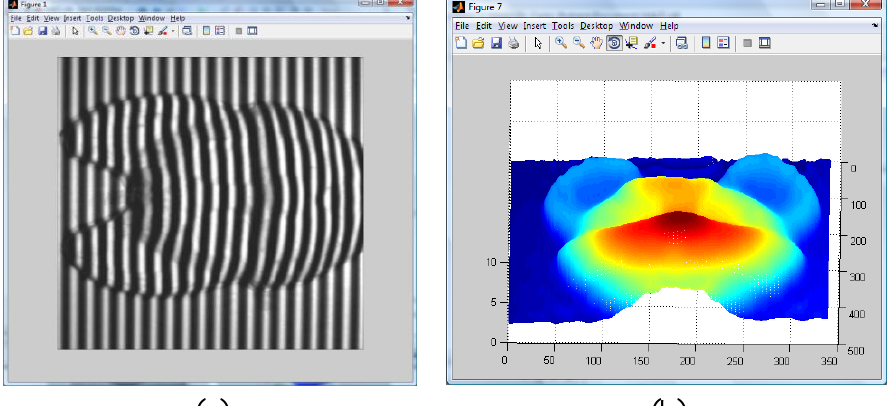
Figure 10. Real objects (a), (c), and (e), and their respective reconstruction (b), (d) and (f) views by using wavelet